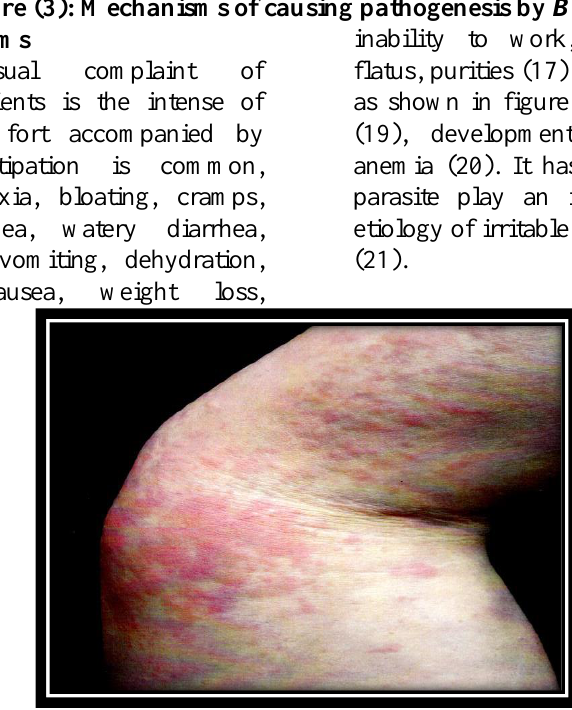
Figure (4):Chronic urticaria caused by Blastocystis